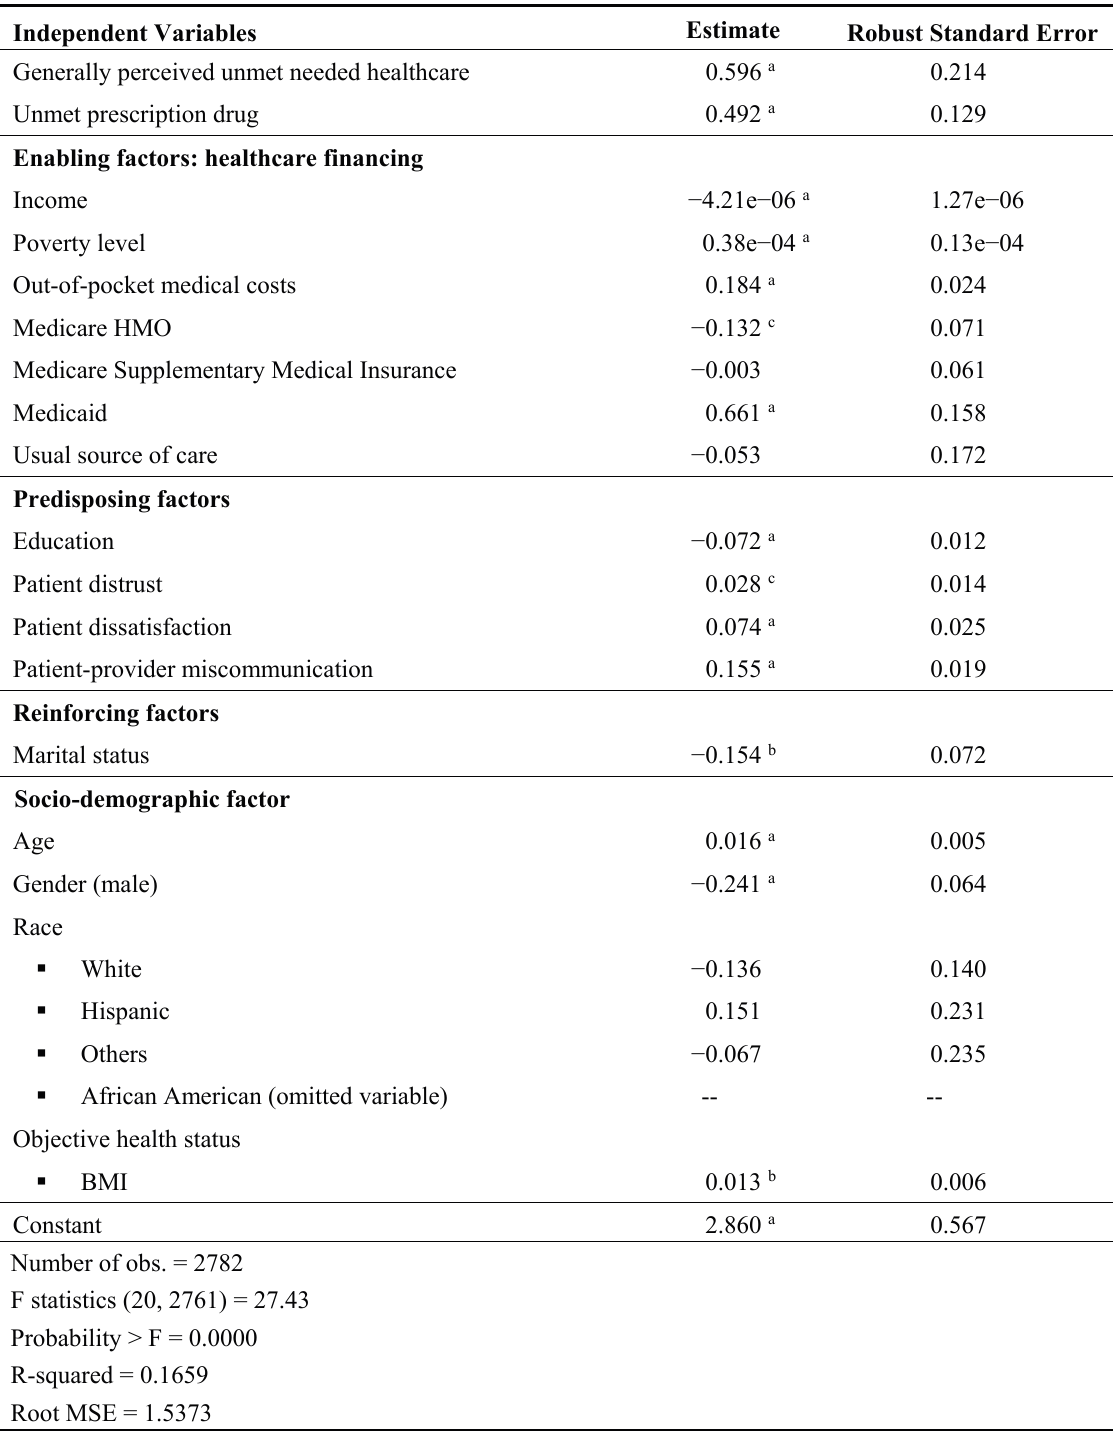
Table 6. Evaluated subjective health (ill health): Elderly of generally perceived unmet needed healthcare (aged 65+)—Results of OLS